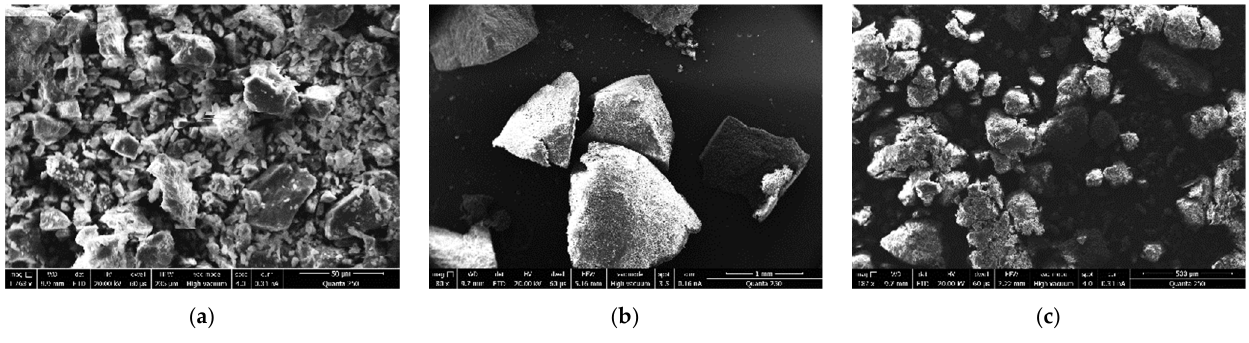
Figure 3. Photographs of raw materials: ( a ) EP; ( b ) WSG; ( c ) RCP.